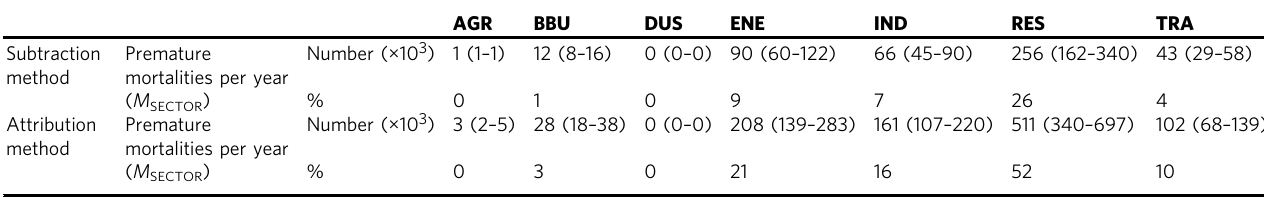
Table 2 Estimated premature mortality associated with ambient PM 2.5 exposure in